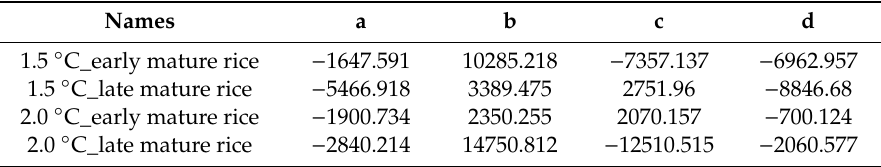
Table 3. The relationship between climatic variables and rice yields.